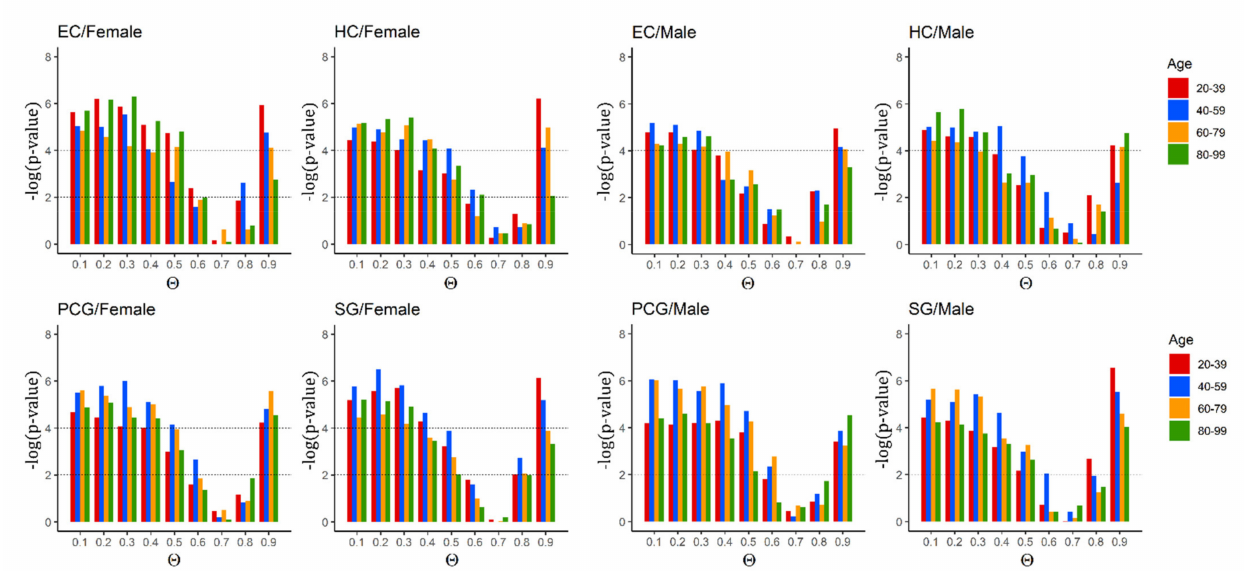
Figure 5. Critical control proteins were significantly enriched and associated with ageing genes across the lifespan from Θ = 0.1 until Θ = 0.5, where Θ = 0.6 shows a transition point. From Θ = 0.7, the increasing bars denote the increasing statistical significance of the depletion of critical protein with known ageing genes. The results are shown for all four brain regions, for each age period and for females ( left ) and males ( right ). Note that p -values are shown as the − log( p -value) in the vertical axis. The horizontal axis indicates the probabilistic parameter Θ